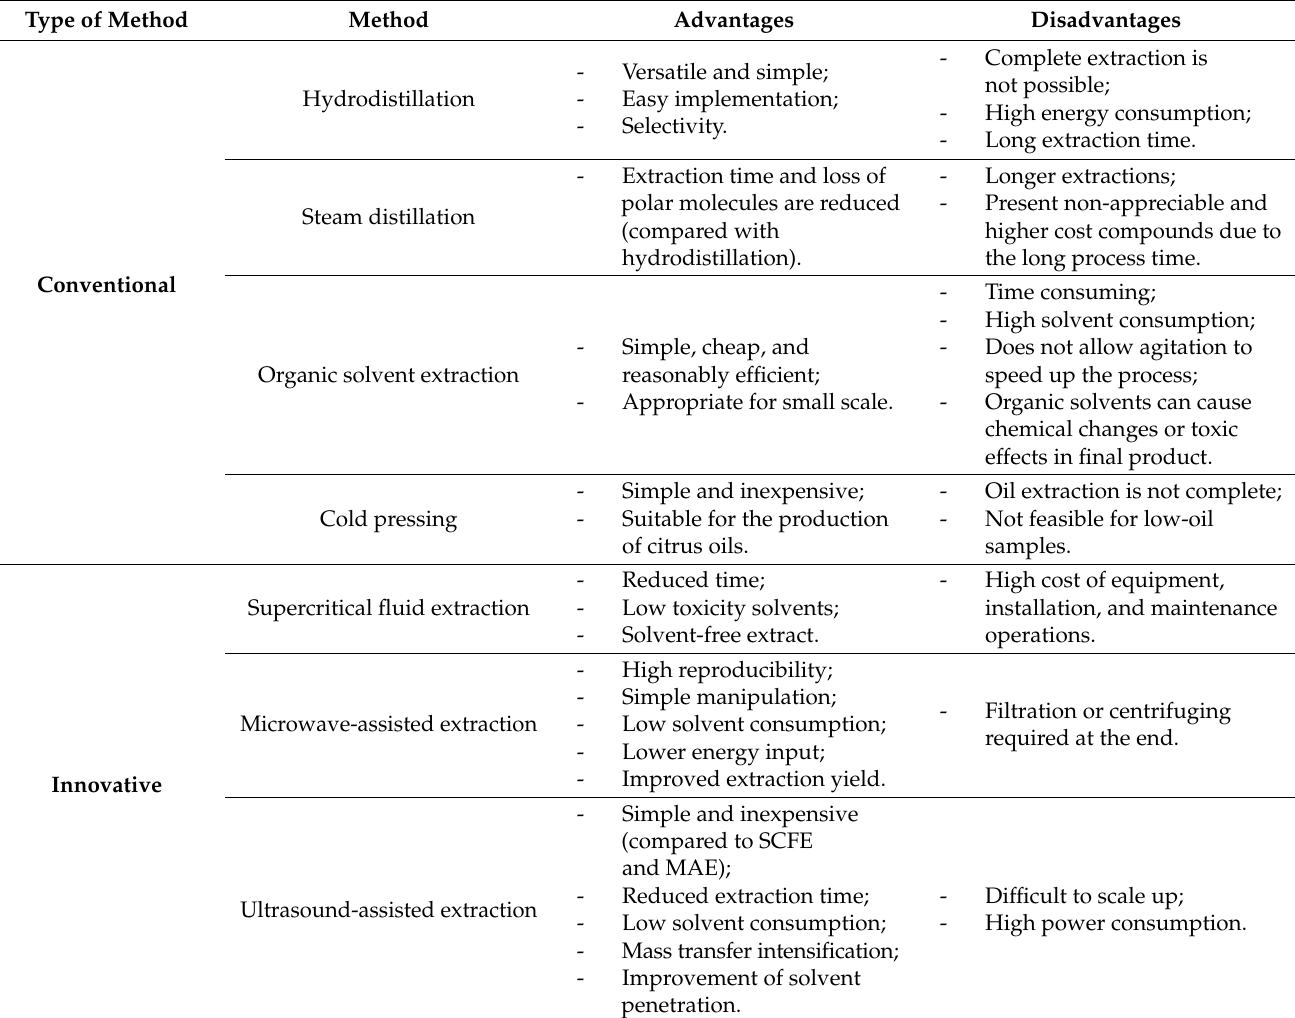
Table 2. Advantages and disadvantages of each essential oil extraction method